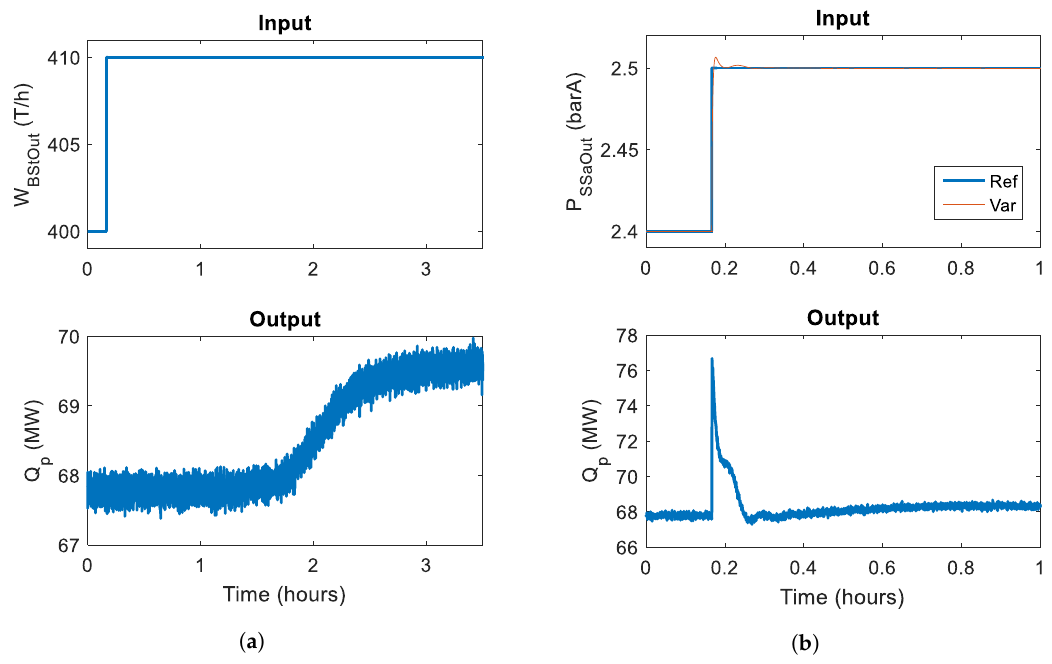
Figure 2. Dynamic response of Q p . ( a ) Dynamic response of Q p for a step in W BStOut ; ( b ) Dynamic response of Q p for a step in P SSaOut